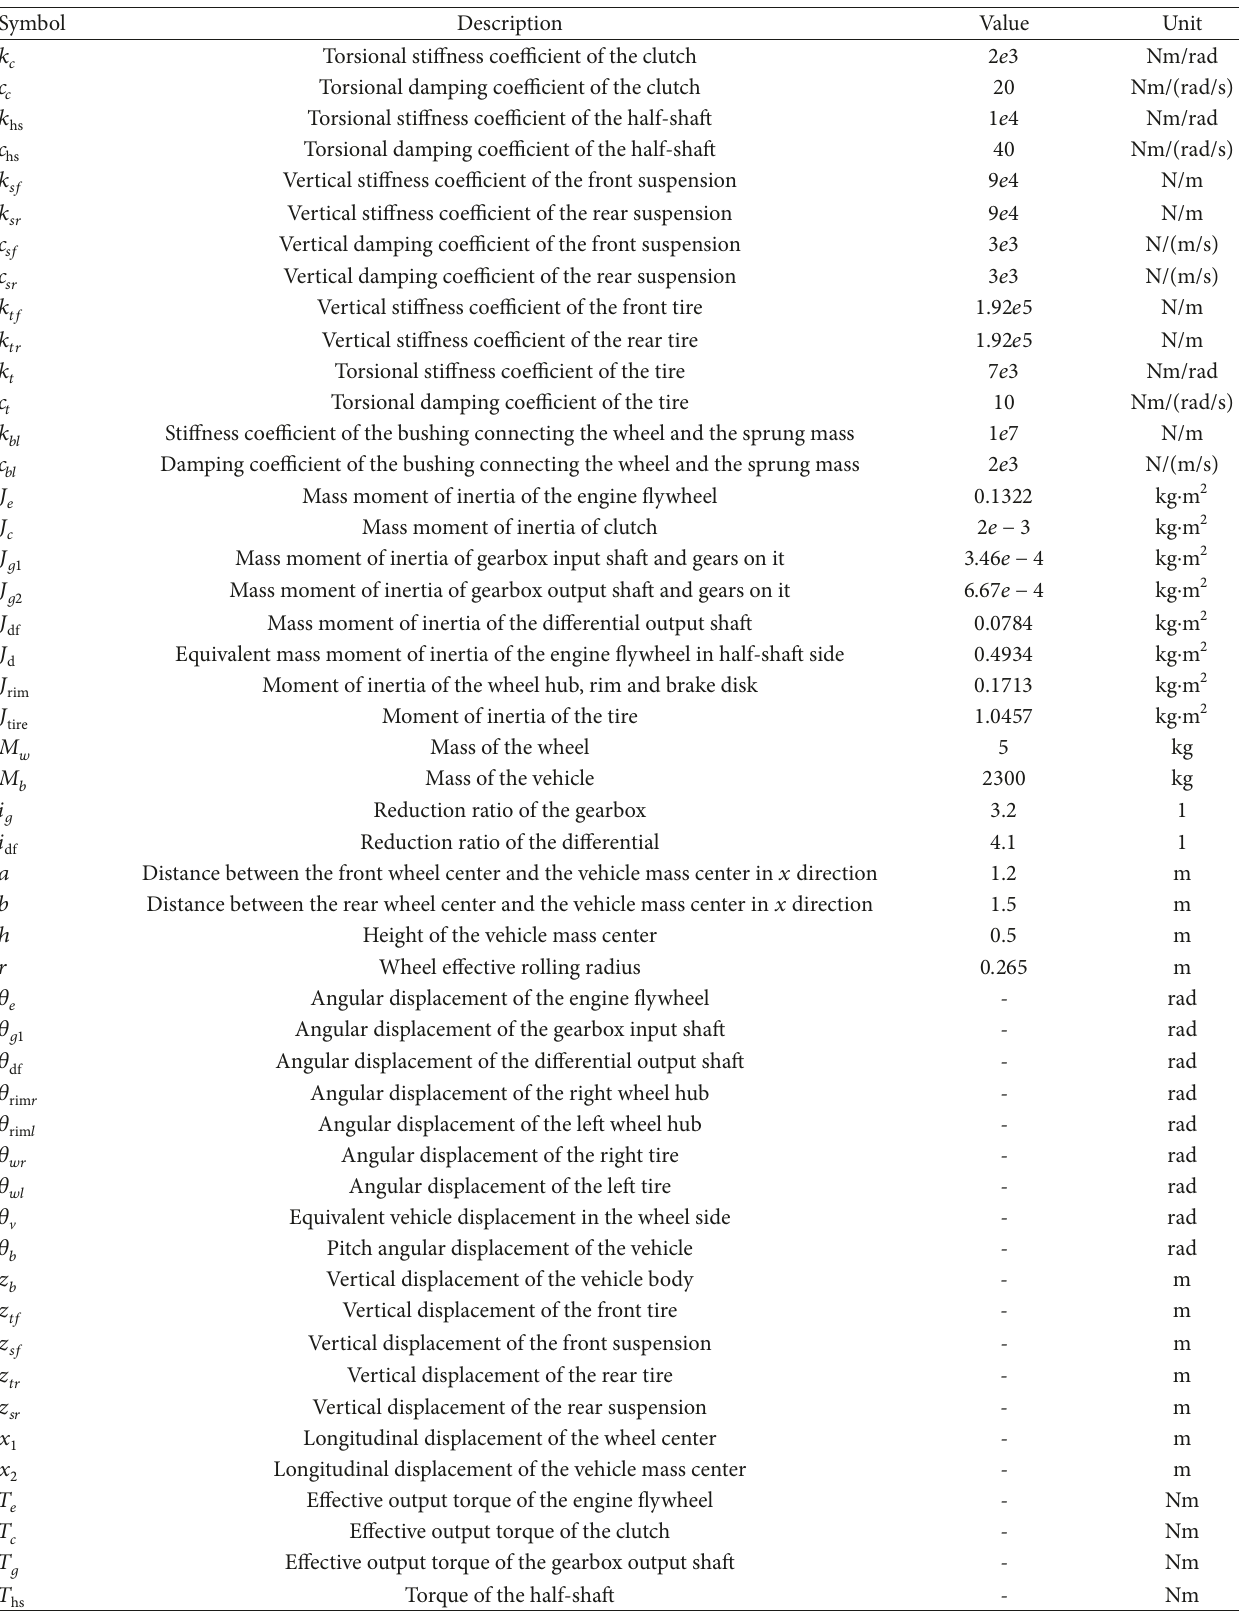
Table 5: Symbol and parameter